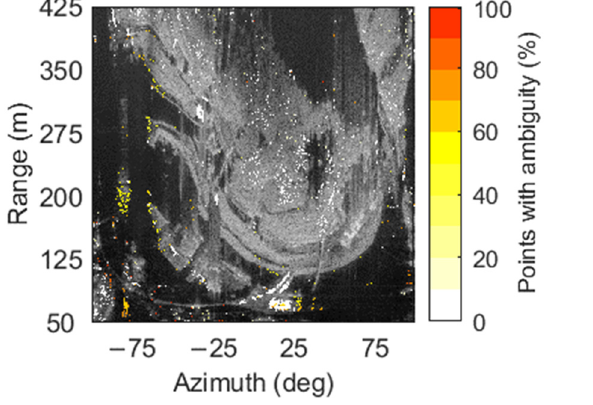
Figure 5. Statistical histogram of the wrapped phase before and after the systematic error correction of five typical interference pairs ( a – e ) in the experimental area. Table 3. Statistics of the phase before and after the systematic error correction of five typical inter- ferometric pairs. Mean